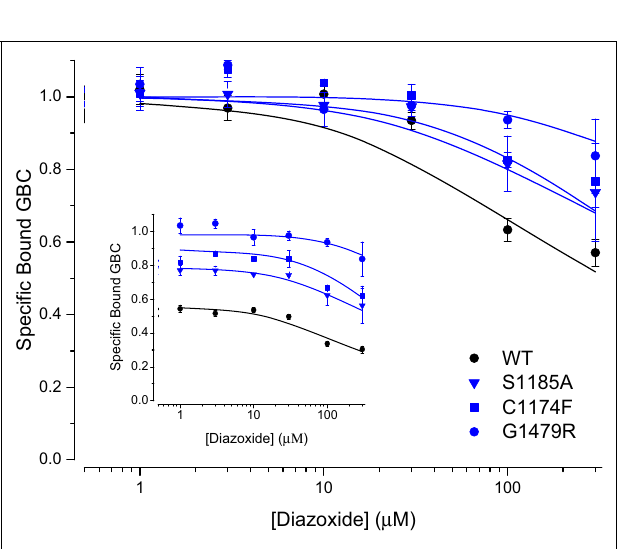
FIGURE 5 | Diazoxide potentiates conformational switching inWT and CHI SUR1 mutants . For comparison, the results are normalized to GBC binding in 1mM MgATP; the data in the inset are normalized to GBC binding in the absence of ATP and show the effect of added nucleotide on each